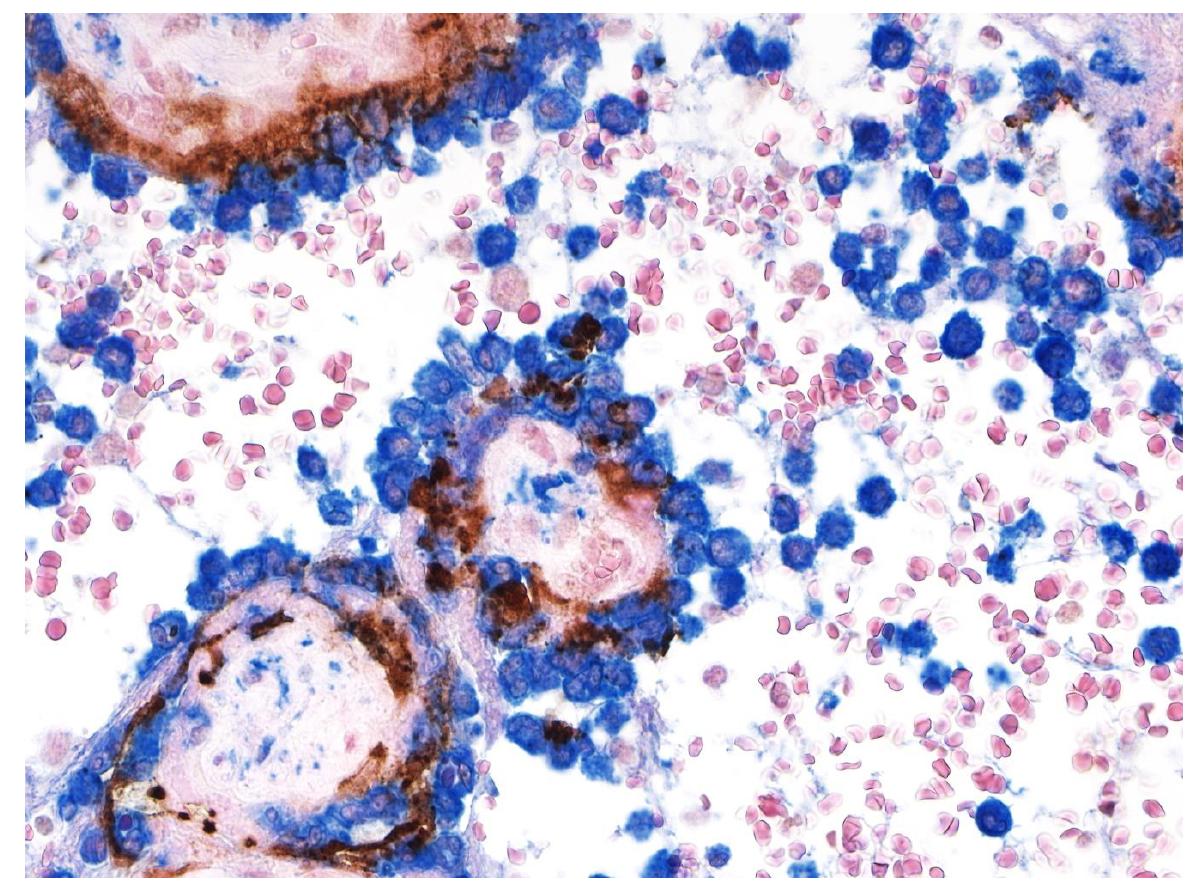
Figure 2. Chronic histiocytic intervillositis. Double-staining immunohistochemistry reveals round-shaped histiocytes in the intervillous space that are strongly positive for CD163 (blue) and surround chorionic villi. The trophoblast layer stains positive (brown) for SARS-CoV-2 nucleocapsid protein. Double staining with antibodies to CD163 and SARS-CoV-2 nucleocapsid protein, nuclear red counterstain. ×40.